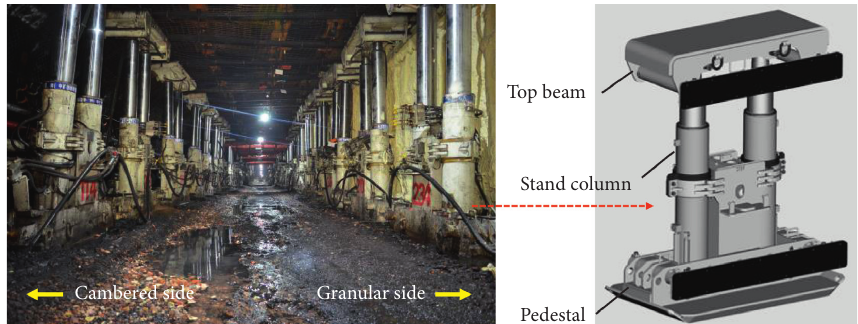
Figure 11: Dynamic mining bearing support of the advance working face.